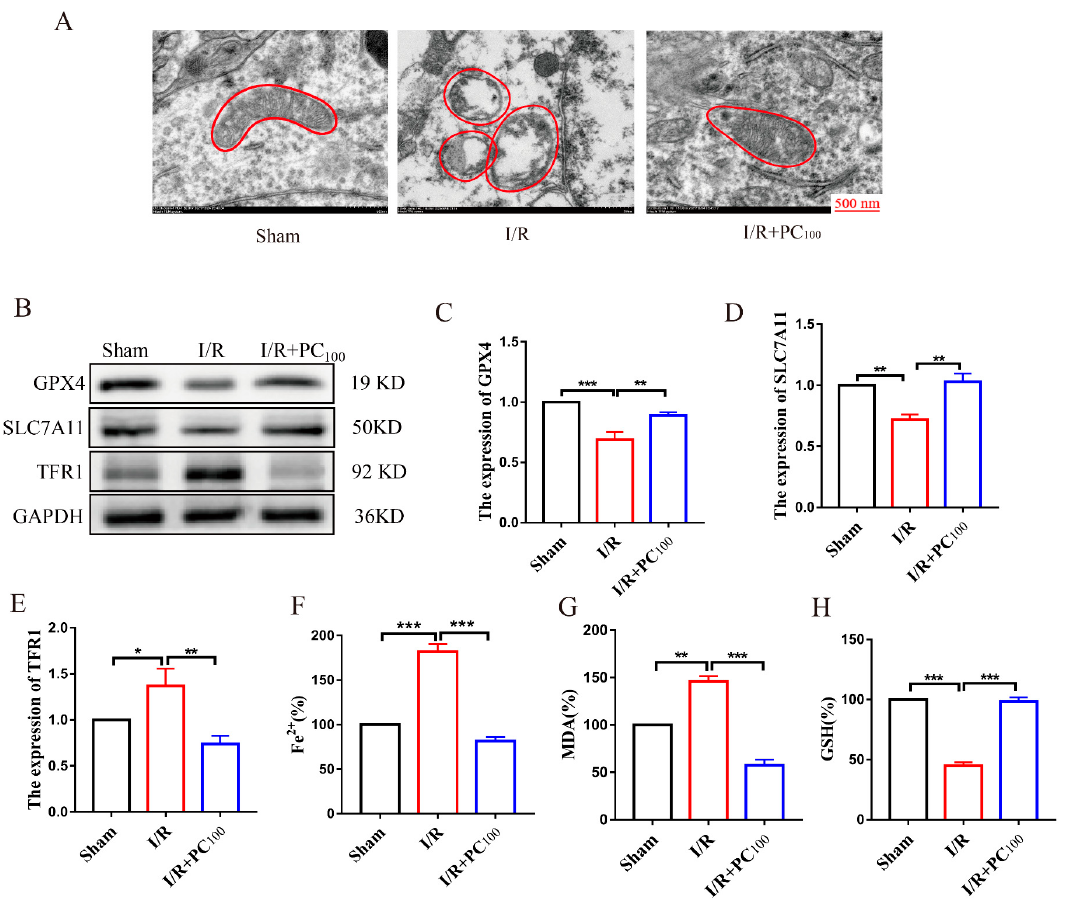
Figure 3. Effects of procyanidin inhibition on cerebral I/R − induced ferroptosis. ( A ) The effect of PC treatment on mitochondrial morphology in mice with CIRI. ( B – E ) The expression of GPX4, SLC7A11, and TFR1 in the brain tissue of mice with CIRI (n = 3). ( F , G ) Level of Fe 2+ and MDA in the brain tissue of mice with CIRI (n = 3). ( H ) Level of GSH in the brain tissue of mice with CIRI (n = 3). All values are expressed as mean ± SD. n.s: no significant difference, * p < 0.05, ** p < 0.01, *** p < 0.001.